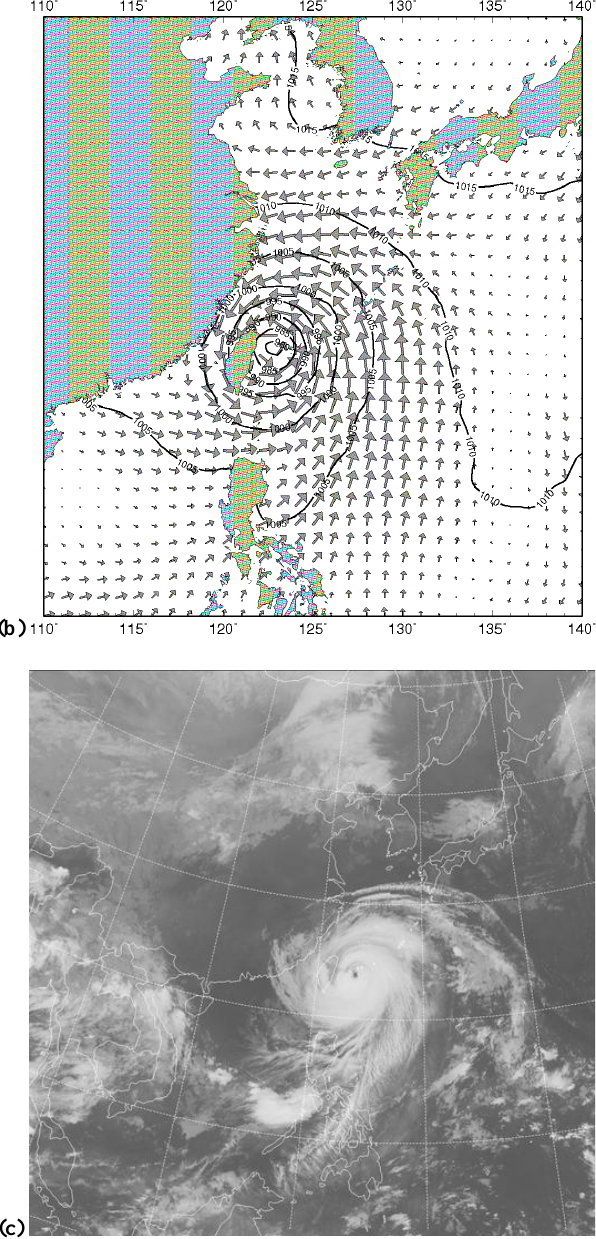
Fig. 2. (bottom) Satellite image of typhoon Krosa at 2009/10/6 07:00 Fig. 2. (b) Wind field provided by CWB (6 October 2009, 13:00). The maximal mean wind speed near the typhoon centre is 51ms − 1